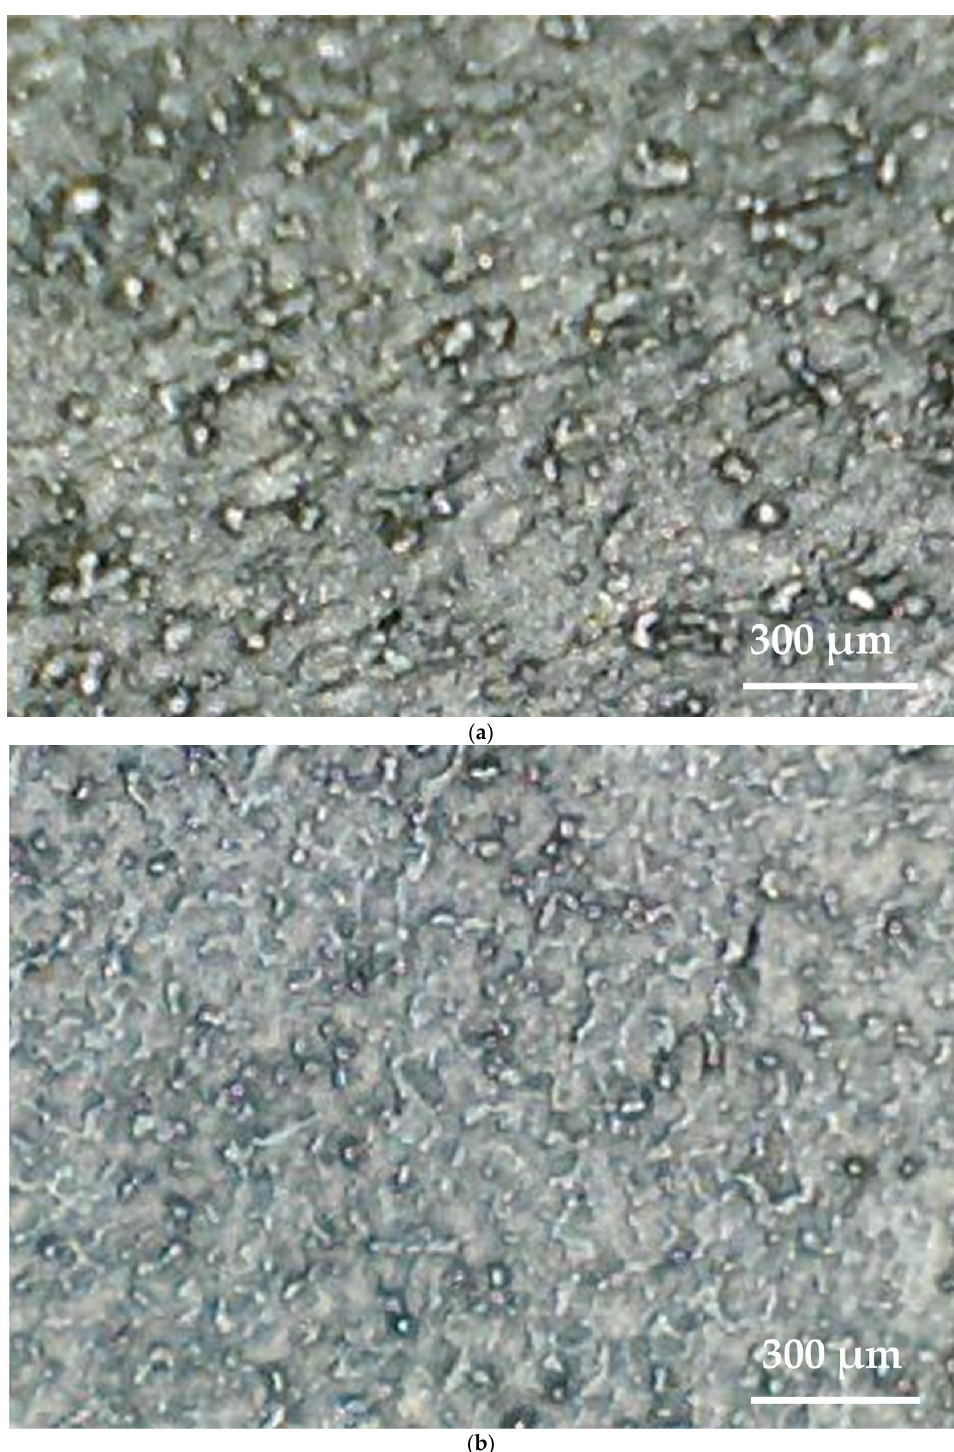
Figure 7. Microphotograph of laser additively produced part surface made of 20Cr13 corrosion-resistant steel of the martensitic class (analog of AISI 420) powder with granules of ≈ 20 µ m (optical microscopy, × 300): ( a ) after production; ( b ) after ultrasonic cavitation abrasive